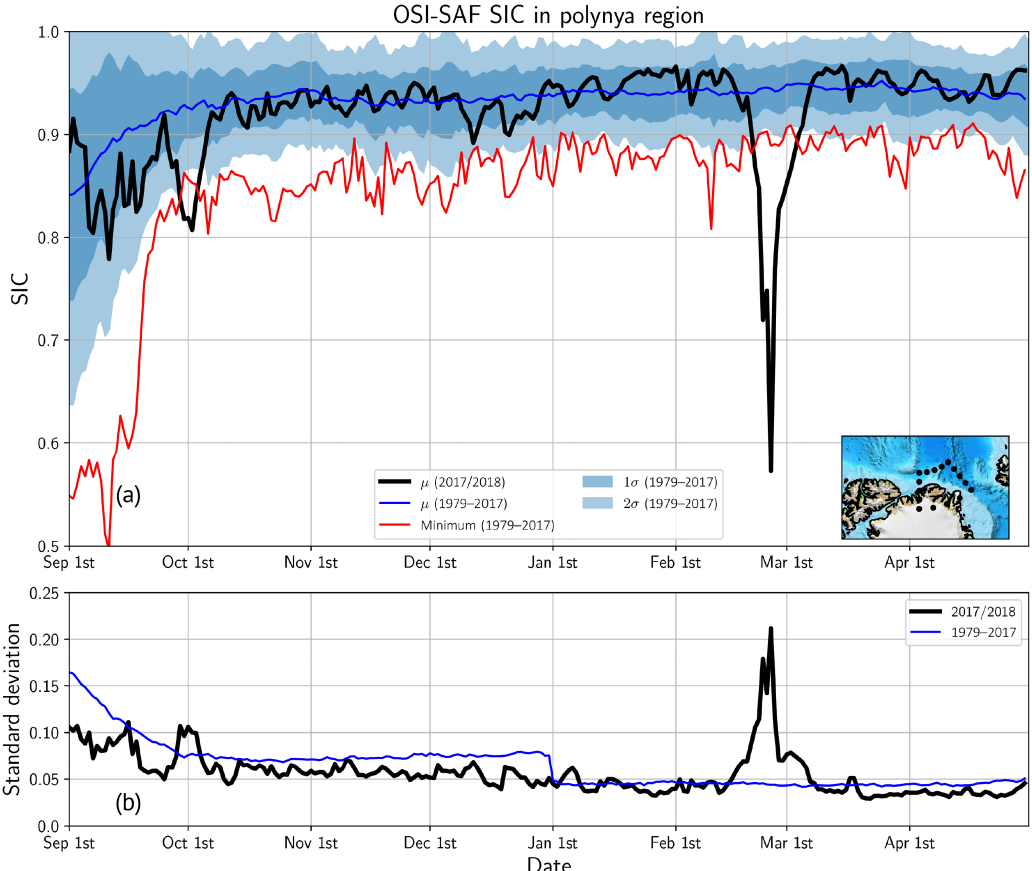
Figure 1. (a) Mean OSI-SAF SIC (Lavergne et al., 2019) in the polynya region (indicated by the dashed box in the map in the lower right corner). The black line shows the mean SIC in 2018. The blue line shows the mean SIC between 1979 and 2017. The dark/light shades indicate the 1/2 σ interval, respectively. The red line shows the minimal mean SIC between 1979 and 2017 for each day. (b) Time series of the standard deviation in the polynya region for 2018 (black). The blue line shows the mean of the standard deviations in the polynya region between 1979 and